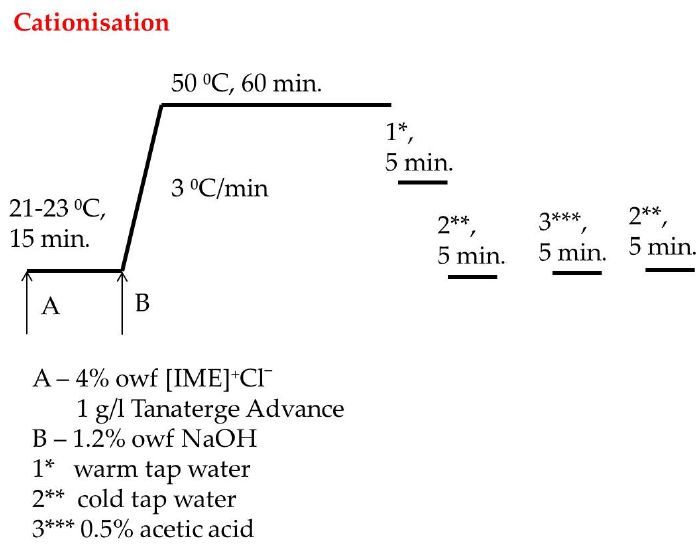
Figure 3. Diagram of catonisation process of cellulose with [IME] + Cl − .